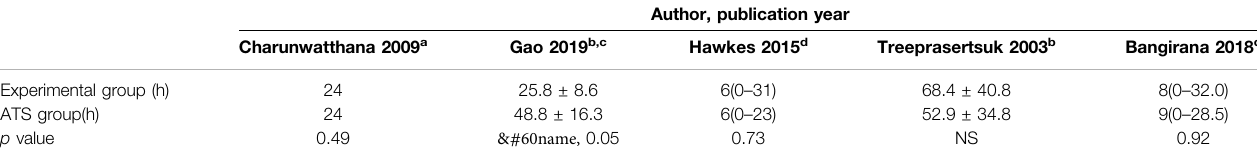
TABLE 4 | FCT levels of ATS monotherapy group and ATS+adjuvant therapy group in patients with severe malaria.